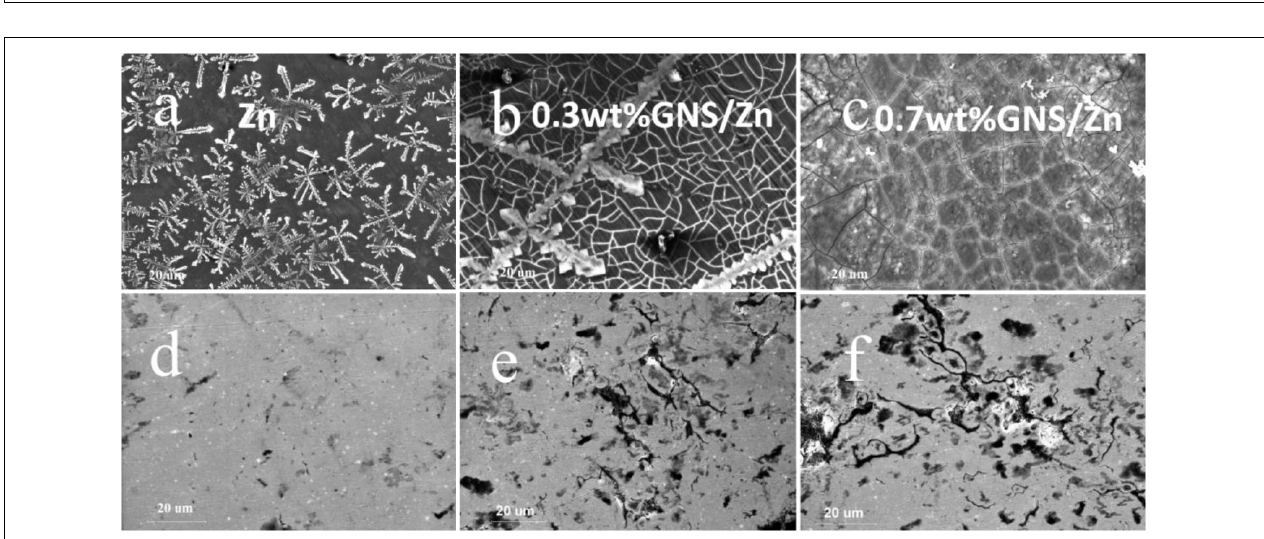
FIGURE 11 | Corrosion product morphology after immersing in SBF solution for 36 days (a) − Pure Zn, (b) − 0.3wt%GNS/Zn, (c) − 0.7wt%GNS/Zn; (d–f) respectively correspond to (a–c) the topography after cleaning with chromic acid.